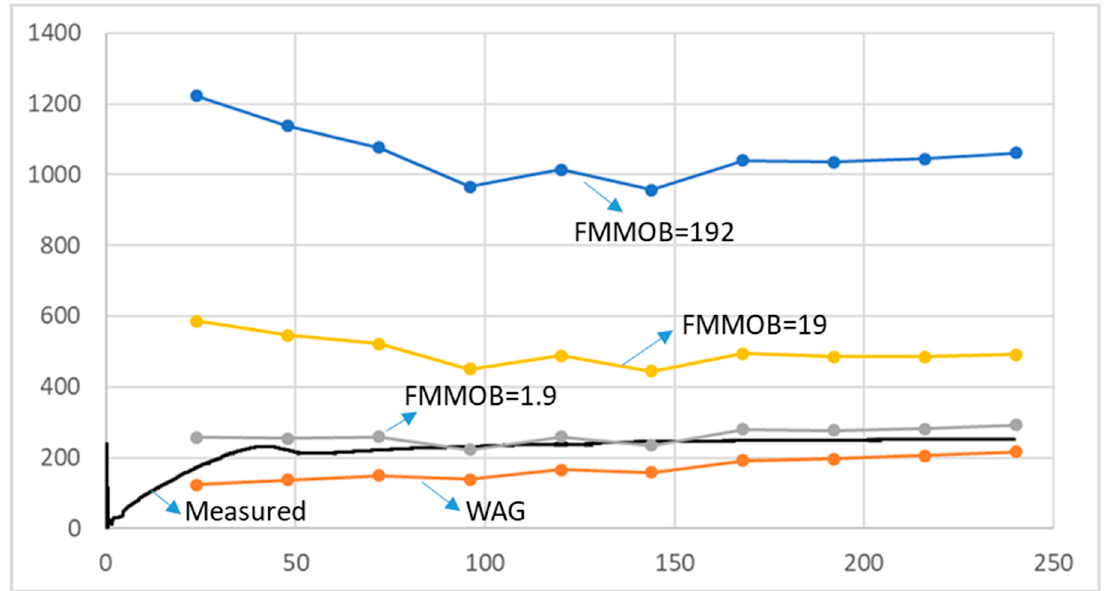
Figure 13. Simulated transient pressures of CO 2 injection during Cycle 8 with different foam strength parameters.